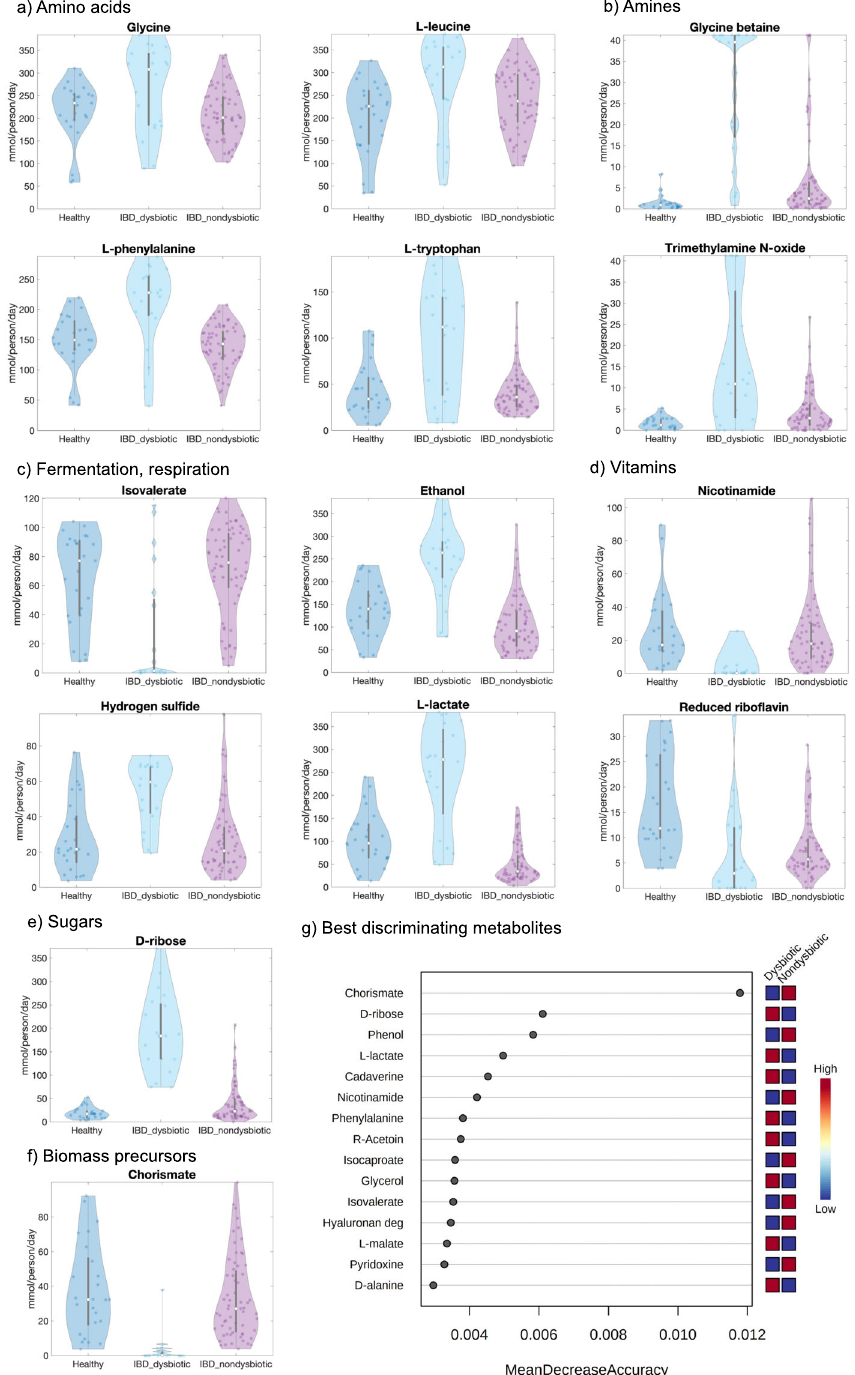
Fig. 2 Predicted metabolite secretion pro fi les for the 108 microbiomes. a – f Total metabolite secretion fl uxes (mmol/person/day) predicted for the microbiomes of 20 paediatric Crohn ’ s Disease patients with dysbiosis (IBD_dysbiotic), 63 paediatric Crohn ’ s Disease patients without dysbiosis (IBD_nondysbiotic), and 25 healthy control children (Healthy) for selected metabolites of interest. g Random forests analysis showing the secreted metabolites that best strati fi ed the 20 dysbiotic and 63 dysbiotic IBD microbiomes ranked by their contributions to classi fi cation accuracy (represented by the variable